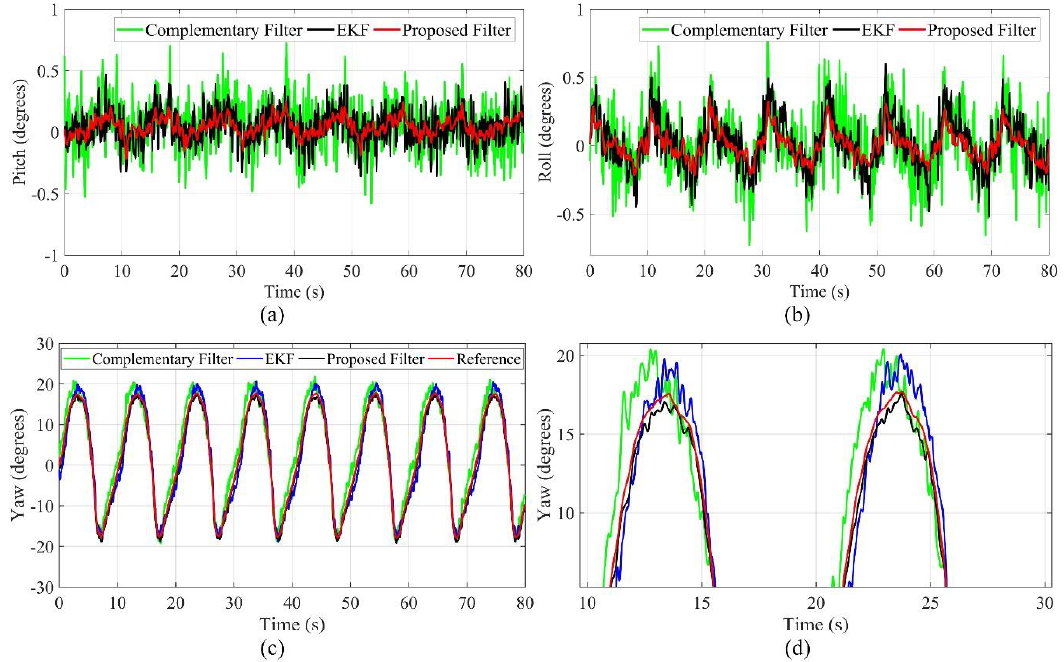
Figure 15. Estimated values of dynamic response test ( a ) pitch angle; ( b ) roll angle; ( c ) yaw angle; ( d ) part details of yaw angle.